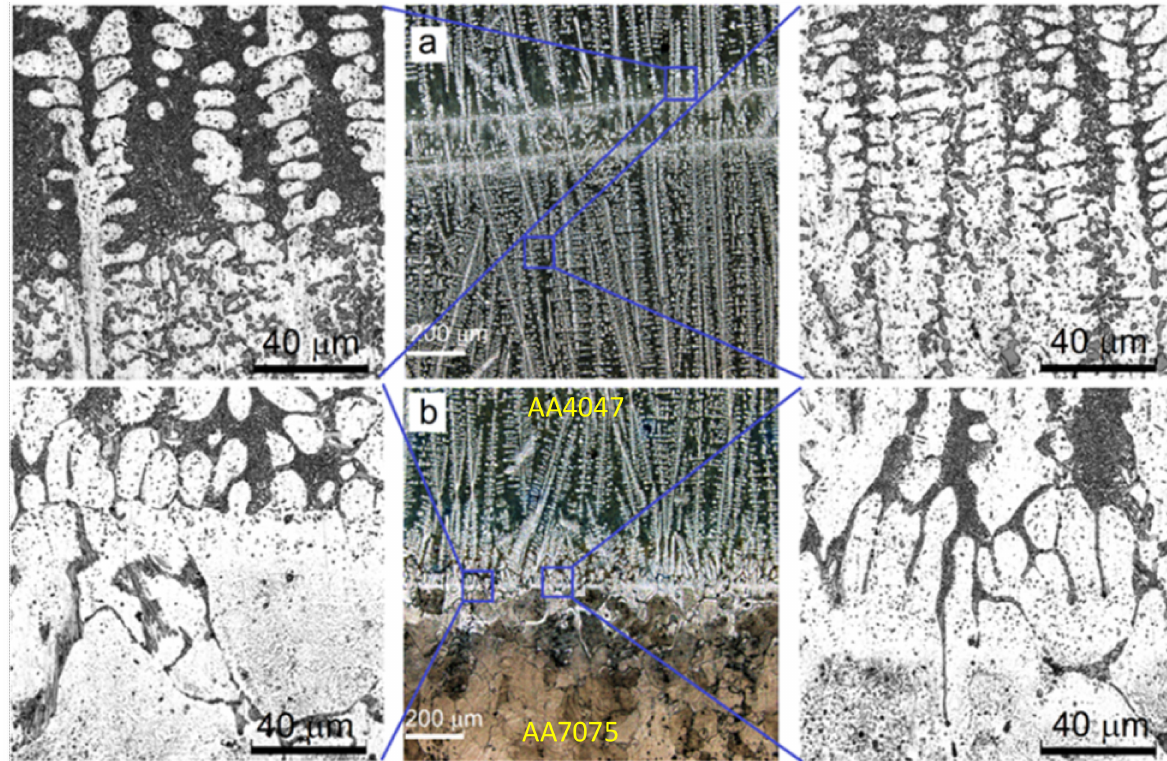
Figure 2. Microstructures in AA4047/AA7075 sample. As-deposited AA4047 zone I ( a ); transition zone ( b